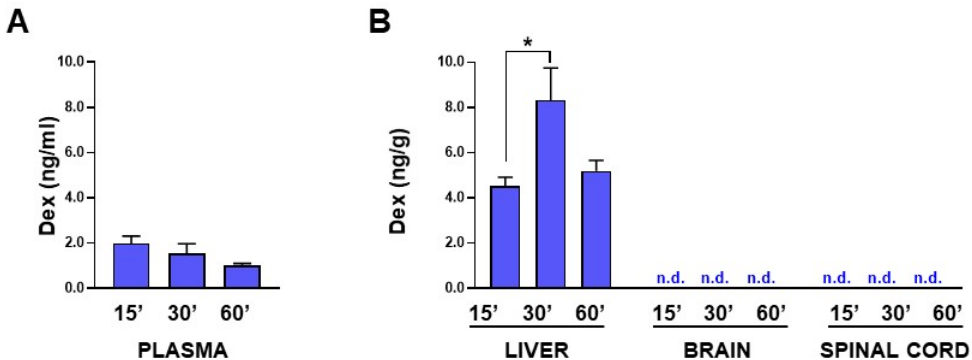
Figure 6. Pharmacokinetics study of free Dex in SOD1 G93A mice. Levels of free Dex measured in plasma ( A ) and liver, brain, and spinal cord ( B ) from SOD1 G93A mice at different time points (15, 30, 60 min) after intravenous administration of ANANAS-Dex. Dex released from the NP was measured by HPLC MS/MS with limit of quantitation (LoQ) equal to 0.01 ng/g for the brain and spinal cord, and 0.1 ng/mL for plasma. Data are mean ± SEM ( n = four in each experimental group); * p < 0.05 by one-way ANOVA, Tukey’s post hoc test. n.d.: not detected.